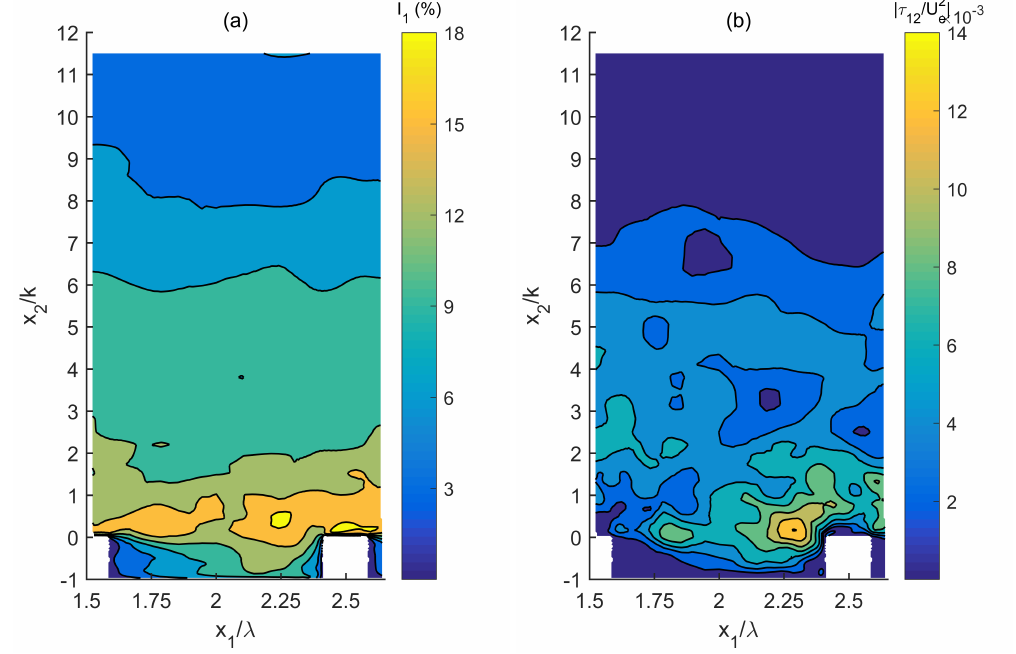
Figure 17. Vertical planes (at x 3 = 0.0375 m) showing predicted distributions of: ( a ) relative turbulence intensity component I 1 ; ( b ) specific Reynold shear stress − u (cid:48) squared U 2 e . The distributions are from LES outputs for Run